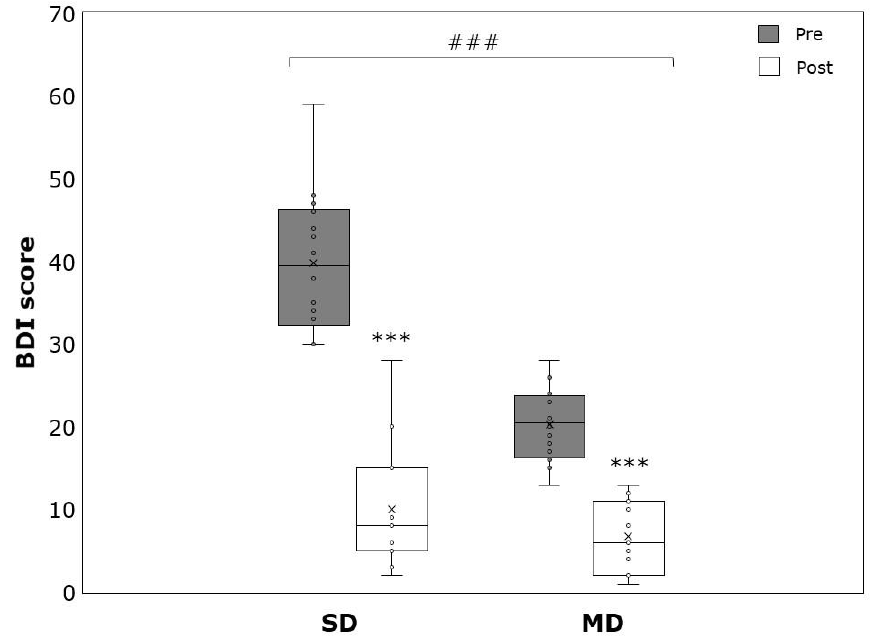
Figure 1. Beck Depression Inventory (BDI) score before (pre) and after (post) the intervention period for severely depressed (SD) and mildly depressed (MD). *** p < 0.001 within-group difference. ### p < 0.001 time × group effects.